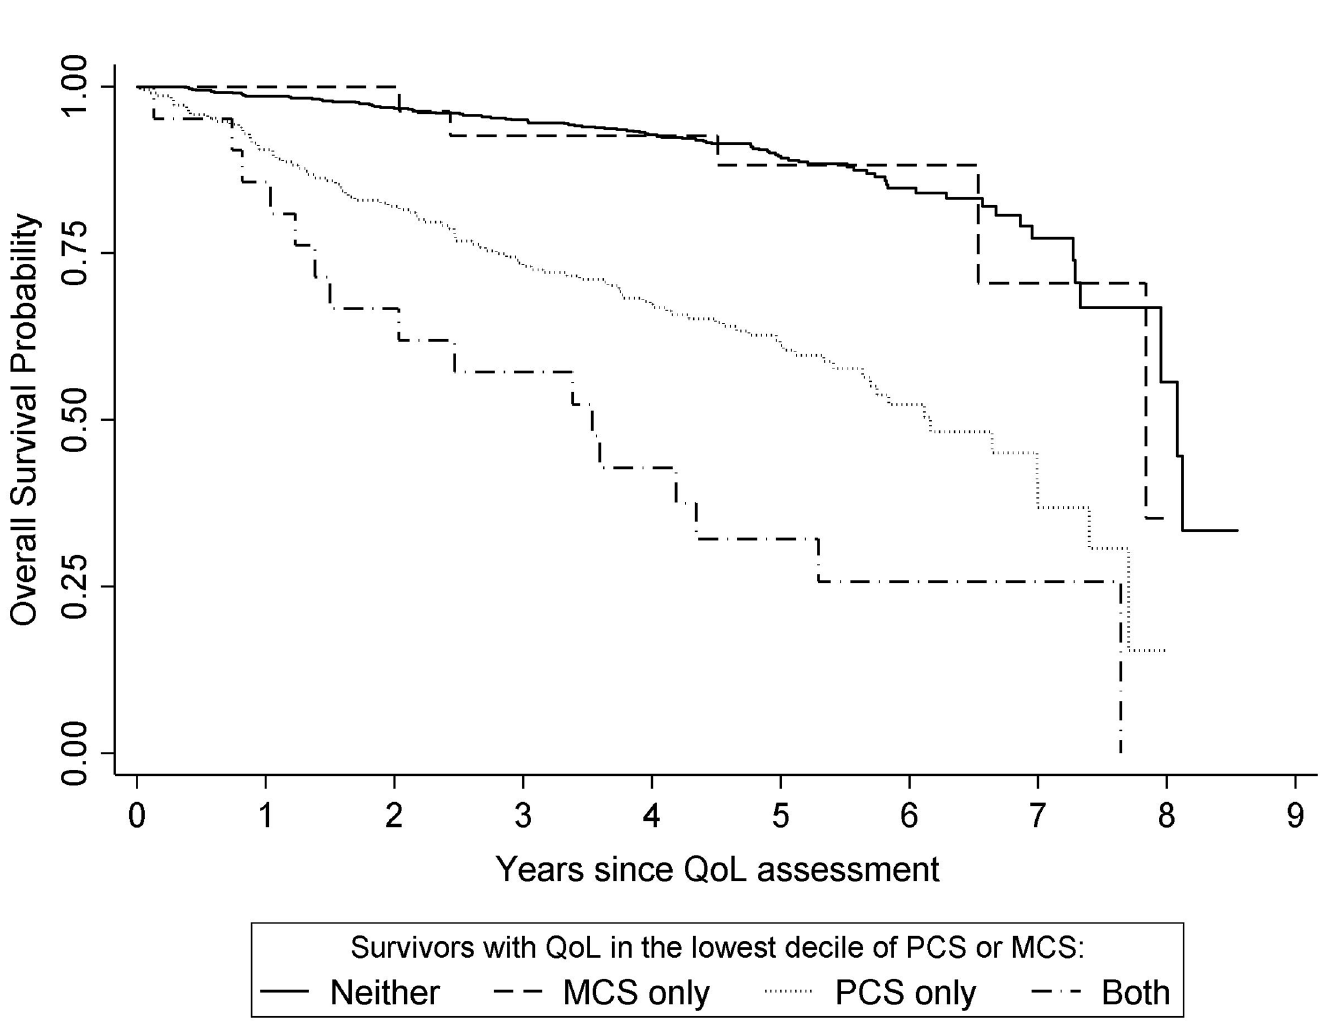
Fig 2. Kaplan-Meier survival curves comparing survivors by Physical Component Summary (PCS) and Mental Component Summary (MCS)